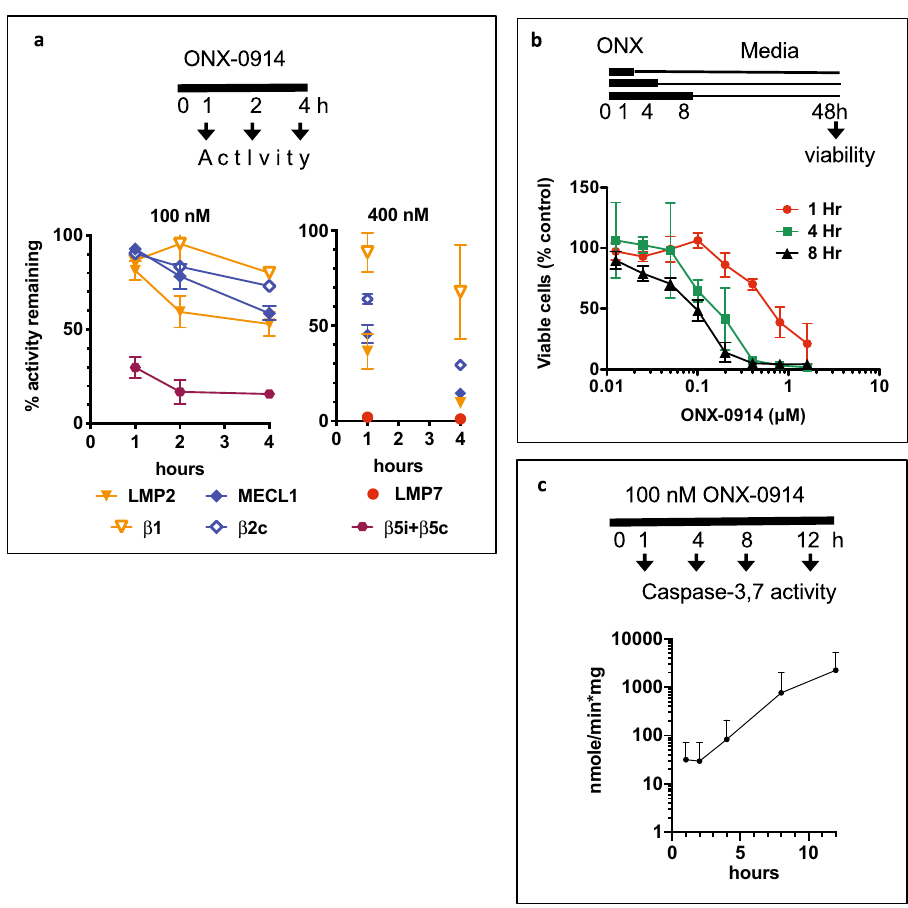
Figure 4. Longer treatment increased proteasome inhibition and cytotoxicity. ( a ) RS4;11 cells were continuously treated with indicated concentrations of ONX-0914. At times indicated inhibition of active sites was determined with either substrates (combined ß5 activity on the left panel, LMP7 and LMP2 activity on the right panel) or a mixture of BODIPY(FL)-NC-001 and BODIPY(TMR)-NC-005 activity-based probes (all others, n = 2). Suc-LLVY-amc was used to measure total ß5 activity on the left panel, the residual activity at 4 h is due to ß5c. ( b ) RS4;11 cells were treated for times indicated, followed by culture in drug-free media. 48 h after the start of the treatment viability was measured with Alamar Blue (top panel, n = 2). ( c ) Caspase-3,7 activity was measured in extracts of RS4;11 cells continuously treated with 100 nM ONX-0914 (n =